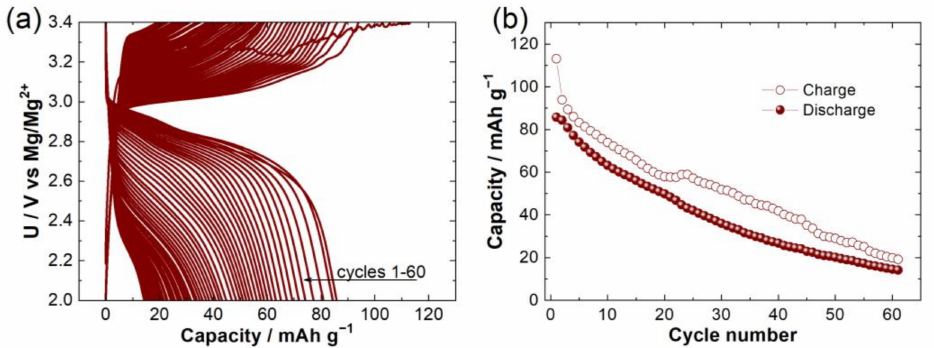
Figure 3. ( a ) Galvanostatic cycling in 0.25 M Mg(HFIP) 2 − 2Al(HFIP) 3 in diglyme electrolyte at C/20. ( b ) Charge and discharge capacities through